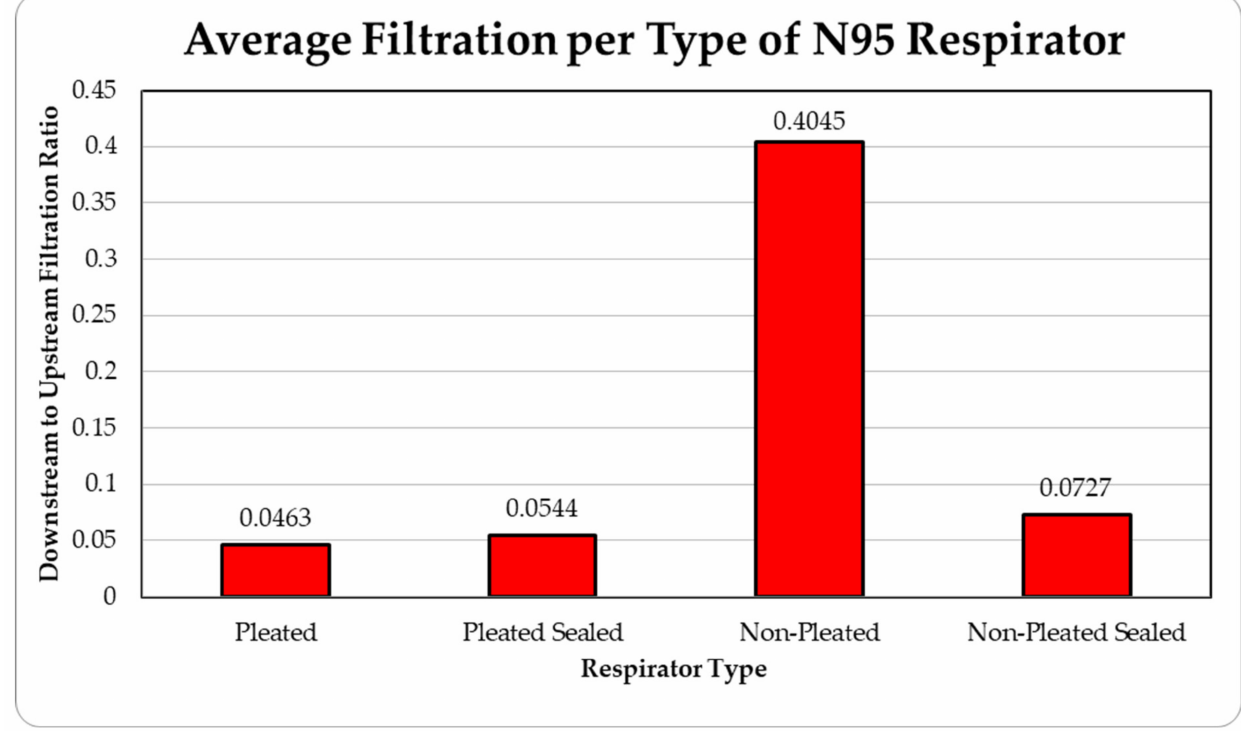
Figure 5. Average filtration ratios of total particles per type and mass at the die casting facility.